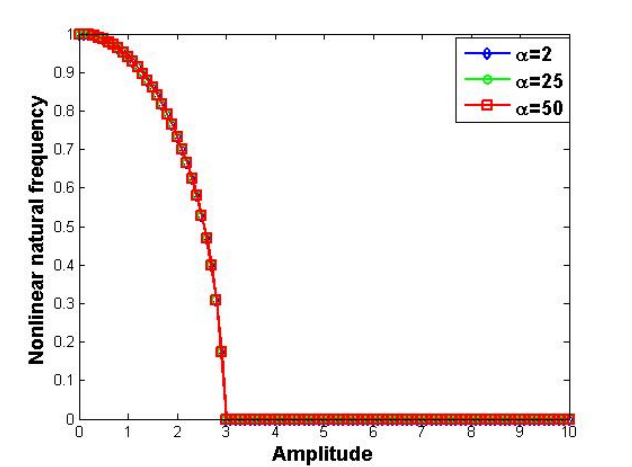
Figure 9. Effects of non-homogeneity of the plate for the nonlinear analysis